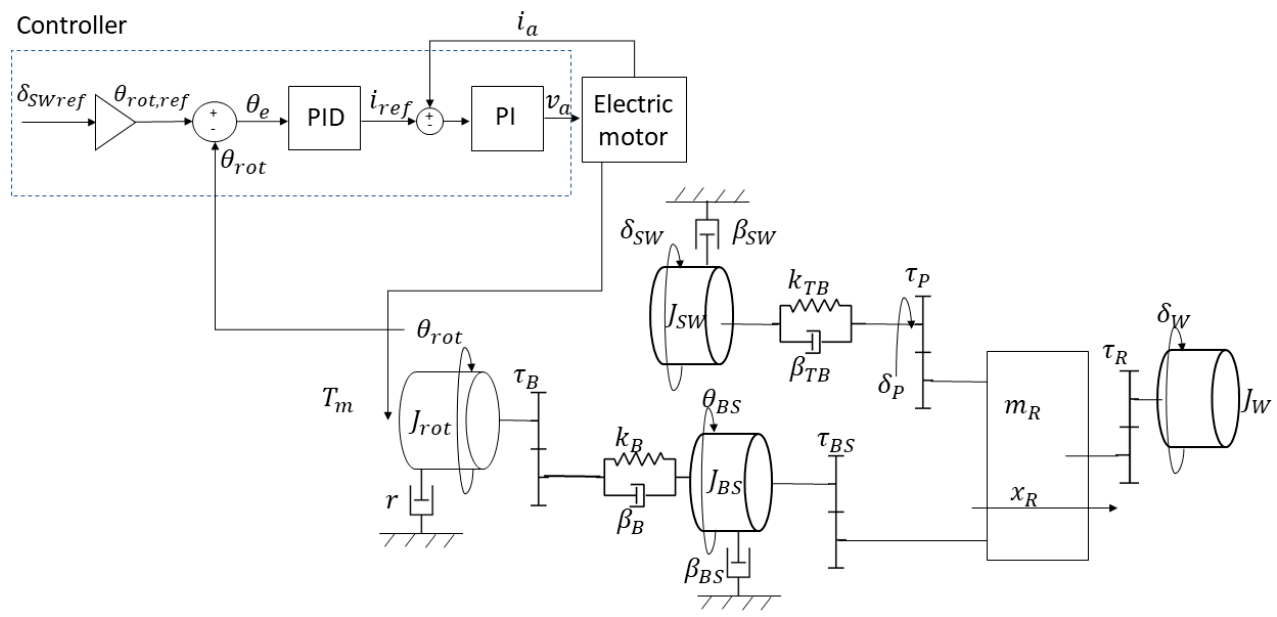
Figure 3. Dynamic model of the studied system.